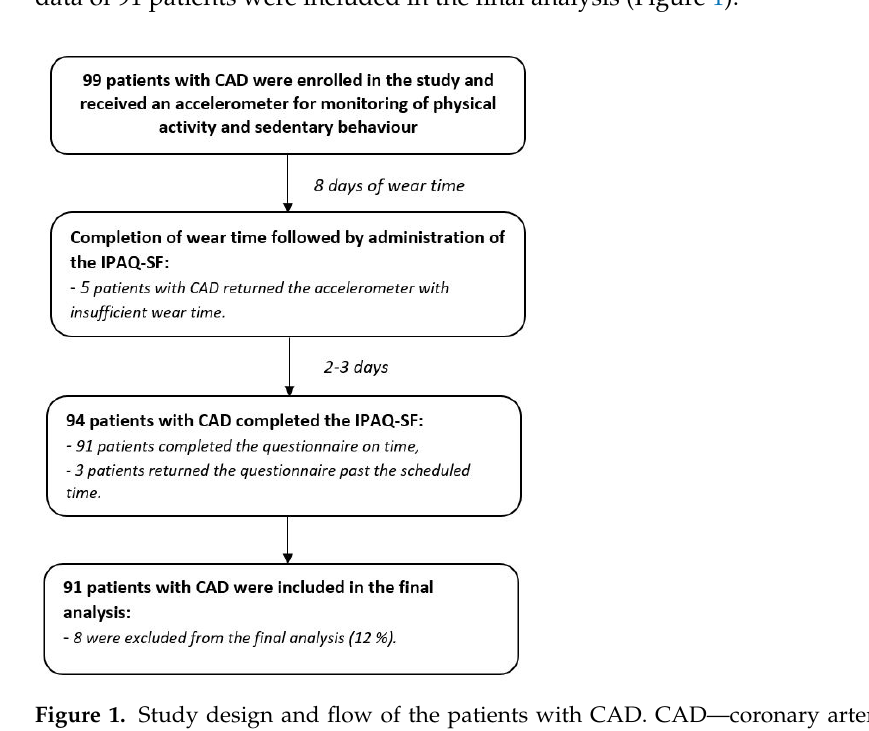
Figure 1. Study design and flow of the patients with CAD. CAD—coronary artery disease; the IPAQ-SF—international physical activity questionnaire short form.